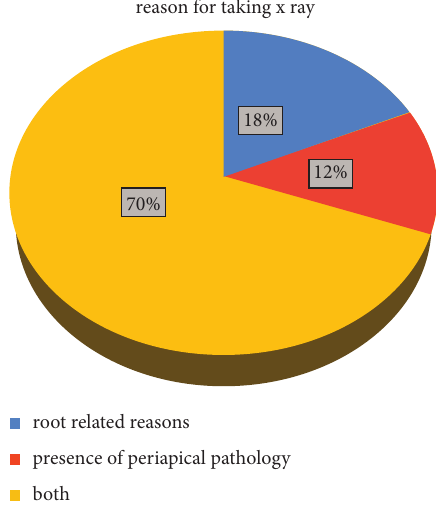
Figure 5: Reasons for taking